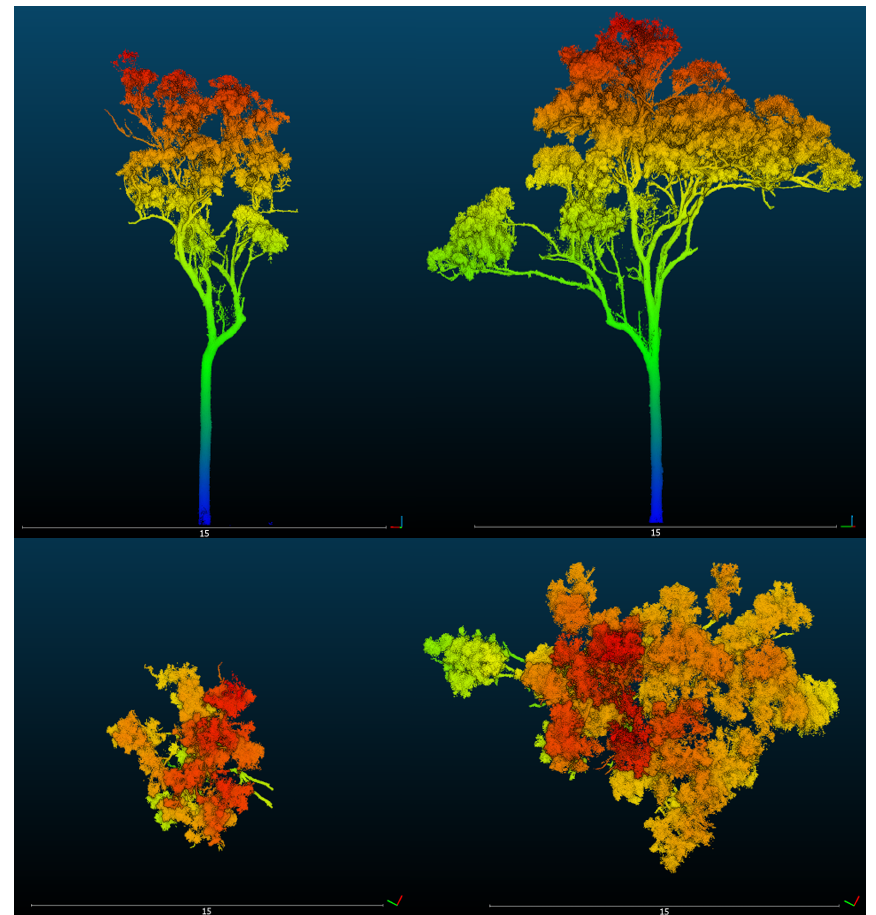
Figure 9. Two examples of typical mature Eucalyptus miniata individuals, both with a DBH of 0.38 m highlighting the dramatic difference in canopy structure, volume and biomass. Estimates of carbon storage of the left individual would be significantly overestimated using a manually measured DBH with allometry